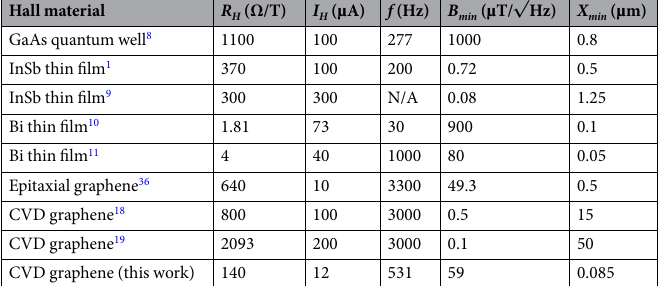
Table 1. A comparison of previous Hall probe architectures at room temperature and low measurement frequencies. The figures of merit include, when applicable, the Hall coefficient, R H , the drive current, I H , the measurement frequency, f , the minimum detectable field, B mim , and the estimated spatial resolution based on the wire width, X min